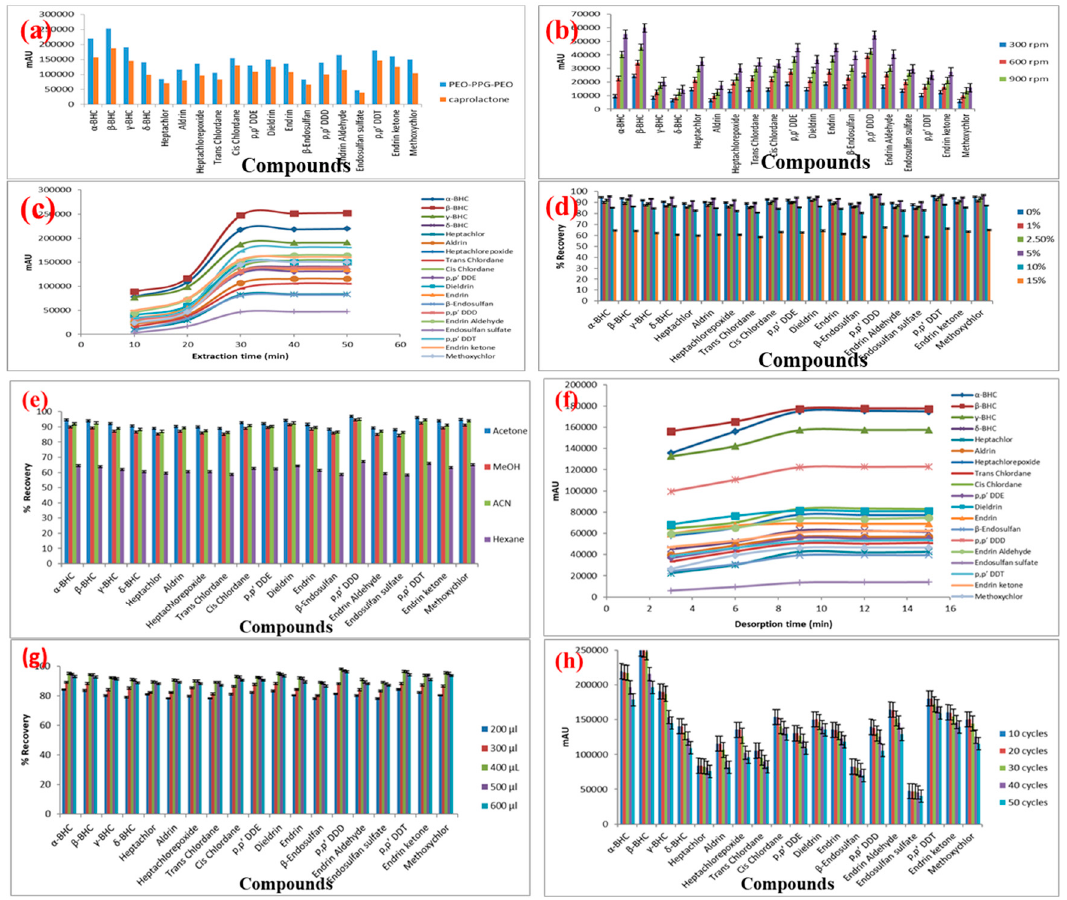
Figure 2. Effect of ( a ) sorbent type; ( b ) agitation speed; ( c ) extraction time; ( d ) salt addition; ( e ) desorption solvent; ( f ) desorption time; ( g ) desorption solvent volume; ( h ) repeated use of FPSE media on the microextraction efficiency of the analytes (sample volume: 10 mL; concentration of the analytes 5 ng/mL).